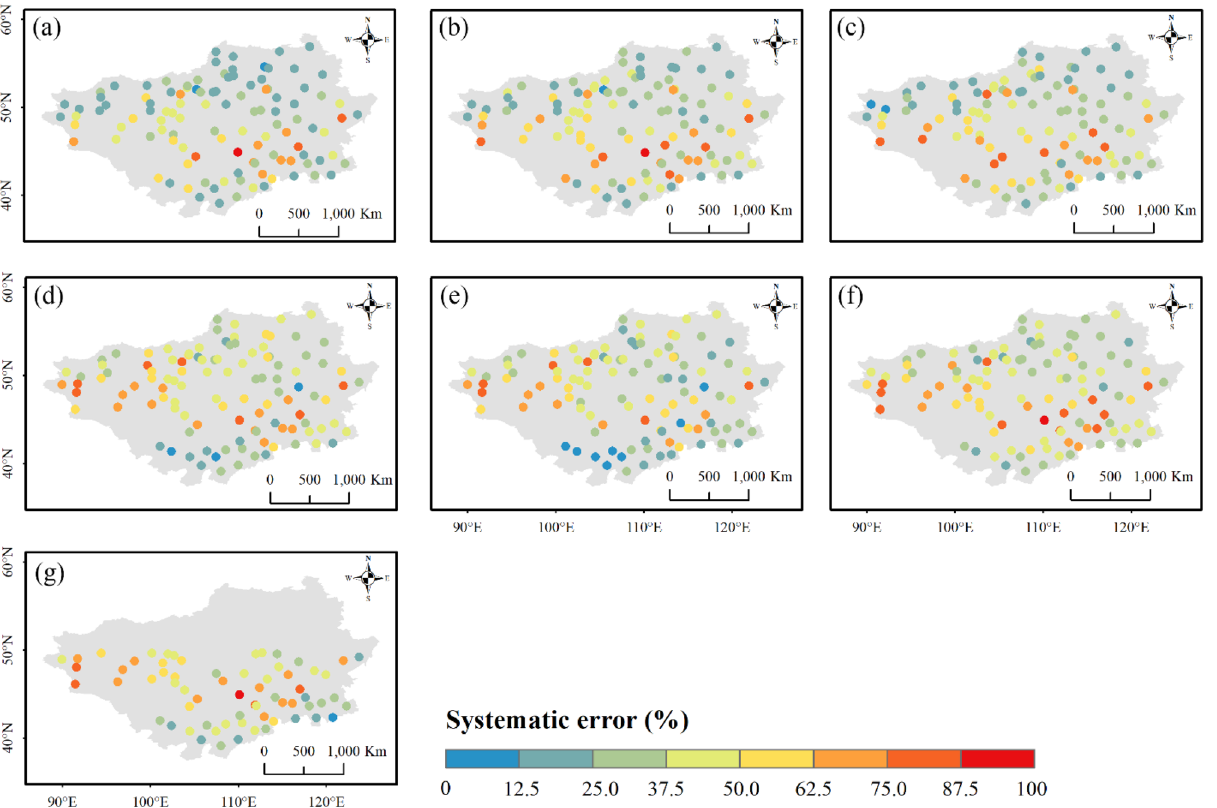
Figure 15. Spatial distribution of systematic errors for ( a ) ERA5-Land, ( b ) ERA5-HRES, ( c ) ERA-Interim, ( d ) IMERG ER, ( e ) IMERG LR, ( f ) IMERG FR, and ( g ) TMPA-3B42 from 2001 to 2018. For subplot ( g ), only stations within the spatial coverage of TMPA-3B42 (50° N–50° S) were plotted. The figure was created using ArcGIS 10.7 (https:// www. esri. com/ en- us/ arcgis/ about- arcgis/ overv iew) 70